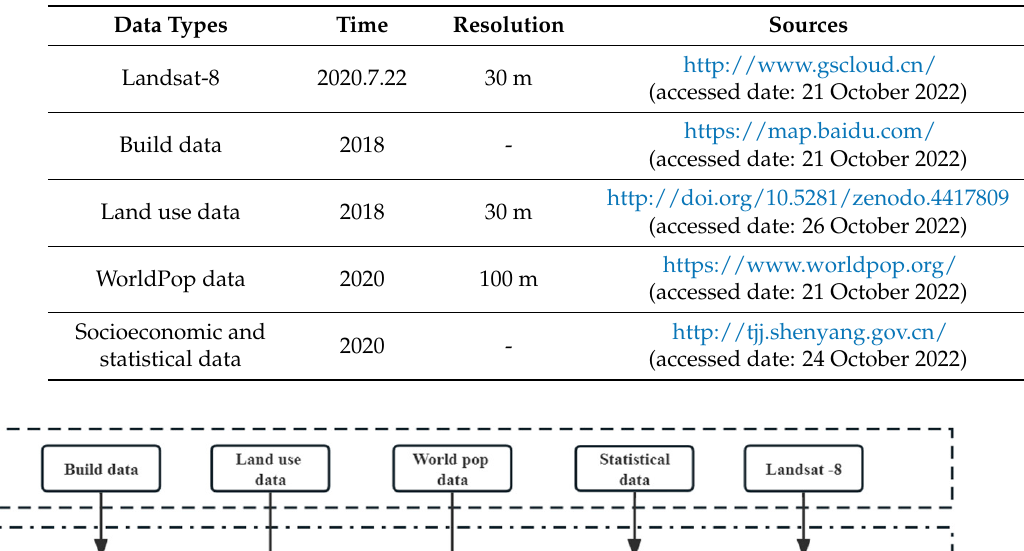
Table 1. Data sources and description.